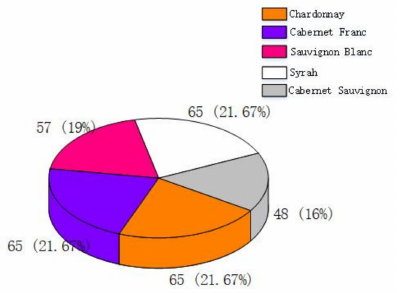
Figure 1. The varieties distribution of WGISD dataset.